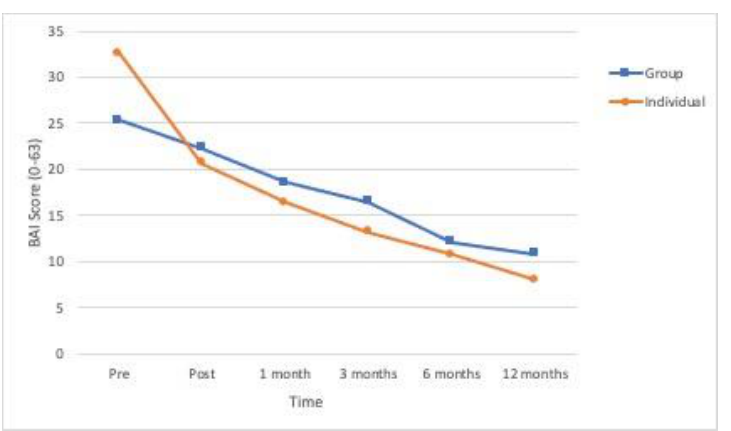
Figure 3. Evolution over time of the levels of depression (Beck Depression Inventory-BDI) in the two experimental conditions ( n = 53).